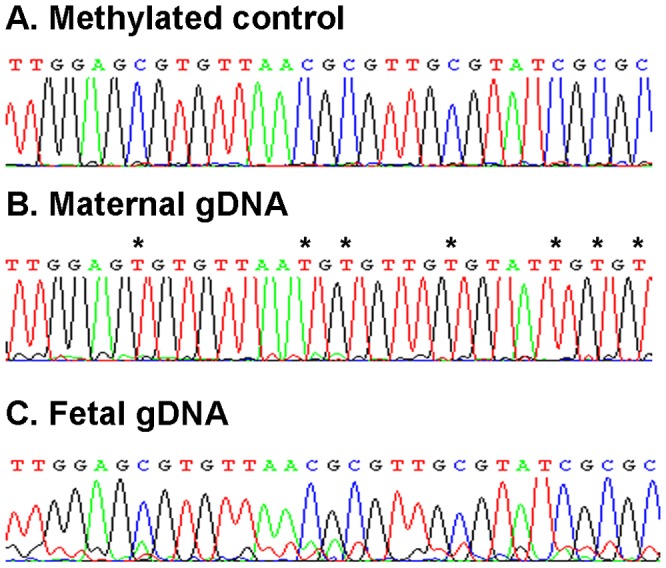
Differentially methylated regions after bisulfite sequencing.Sanger sequencing results for RASSF1A of a fully methylated control cell line (A), maternal gDNA (B) and fetal gDNA derived from CVS (C) after bisulfite sequencing. A representative part of the complete sequence is shown. All unmethylated cytosines are converted to uracil after bisulfite sequencing. Differences between maternal and fetal (methylated) sequences are indicated with an *.